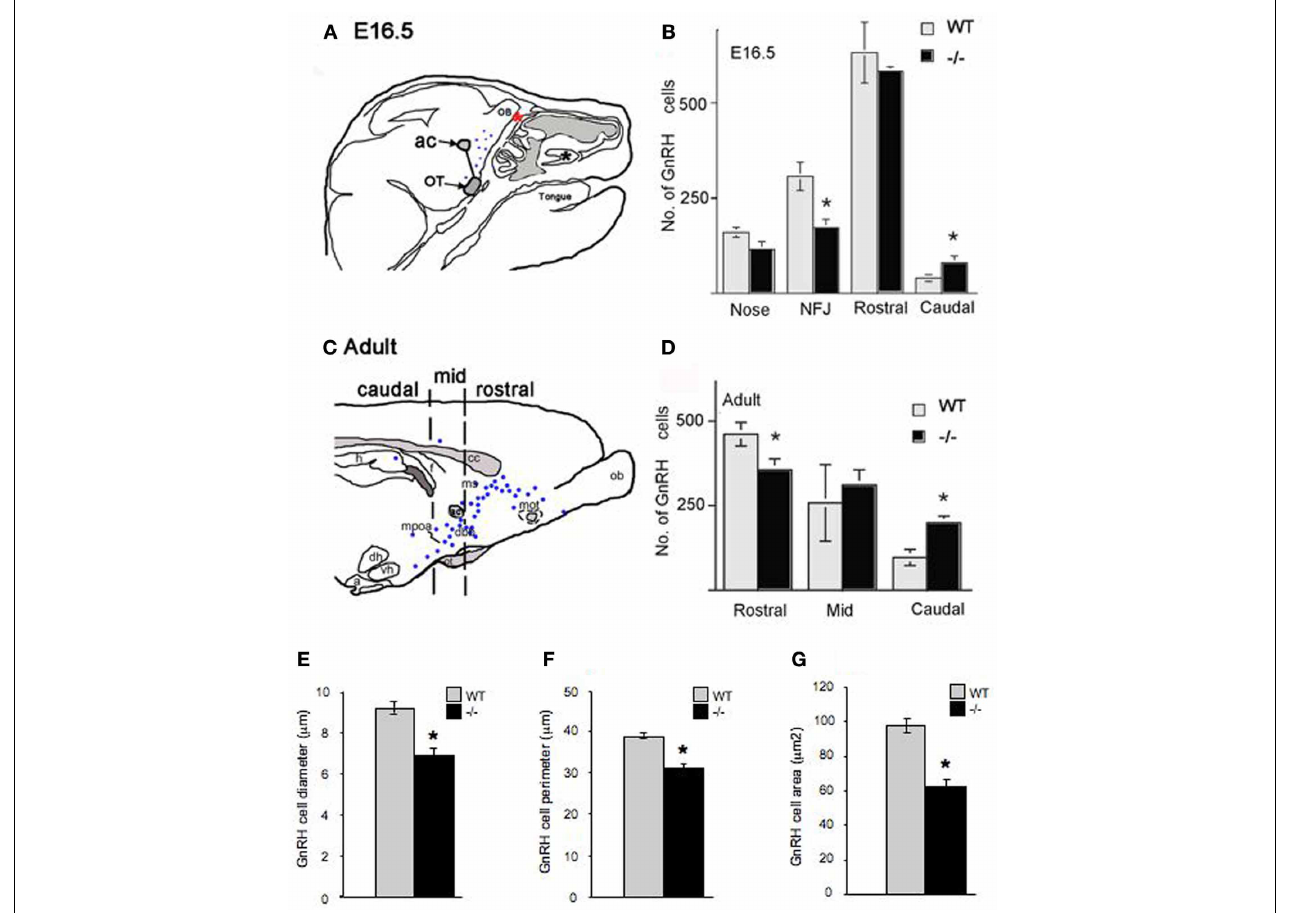
FIGURE 3 | Altered morphology and distribution of GnRH neurons in p75NGFRmutant (-/-) embryos. At E16.5, the majority of GnRH neurons have migrated into the forebrain associated with a subpopulation of olfactory axons. (A) Camera lucida of E16.5 sagittal head showing nasal forebrain junction (red asterisk) and location of anterior commissure (ac) and optic tract (OT) that were used as markers, from which a diagonal line was drawn separating rostral from caudal GnRH cell population. GnRH cells were found in the nasal area [between the VNO (black asterisk) and nasal forebrain junction (NFJ, red asterisk)], at the NFJ, and within the forebrain (black dots). (B) Histogram showing distribution of GnRH cells in the nasal and brain